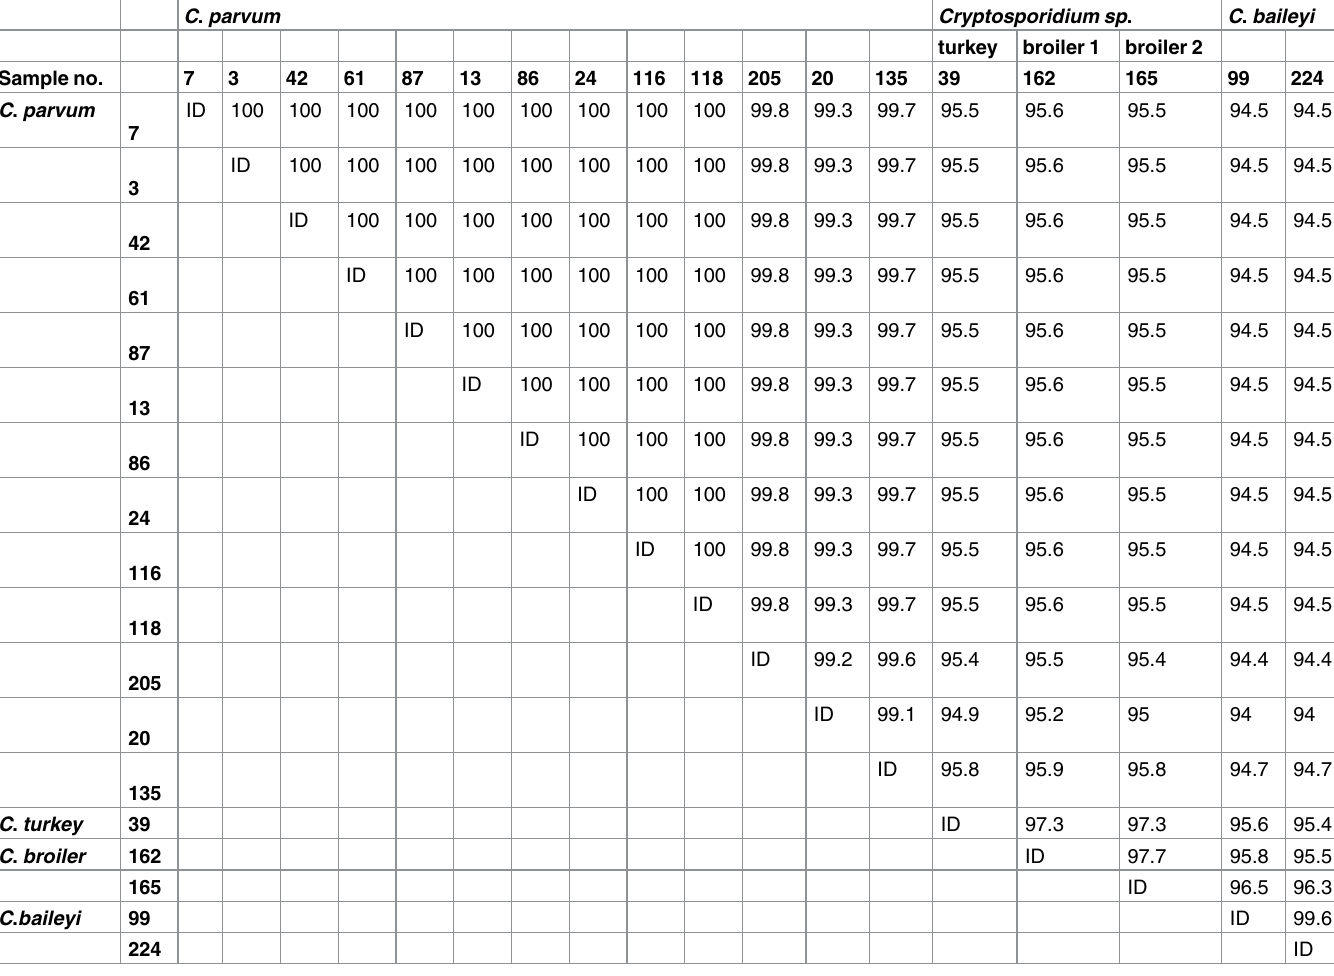
was observed in broilers [39]. The overall infection rates with Cryptosporidium in China were reported to be 3.4% in broilers and 10.6% in layers chickens using bright-field microscopy of fecal samples after concentration of oocysts with the Sheather’s sugar flotation technique [27]. In Brazil, presence of Cryptosporidium DNA in feces was observed in 86% of the chickens using PCR [4]. The differences in prevalence rates observed might be attributed to the use of different detection methods (e.g. microscopic examination vs . PCR) and sample origin (tissue samples vs . feces). Moreover, differences in hygiene and management practices may also be responsible with low infection rates in birds related to efficient management and high infec- tion rates related to poor hygiene, overpopulation and keeping different species of birds together [4,27,40]. Table 3. Nucleotide identity between 18S rDNA gene of Cryptosporidium genotypes detected from chickens and turkeys in Germany. C . parvum Cryptosporidium sp . C . baileyi turkey broiler 1 broiler 2 Sample